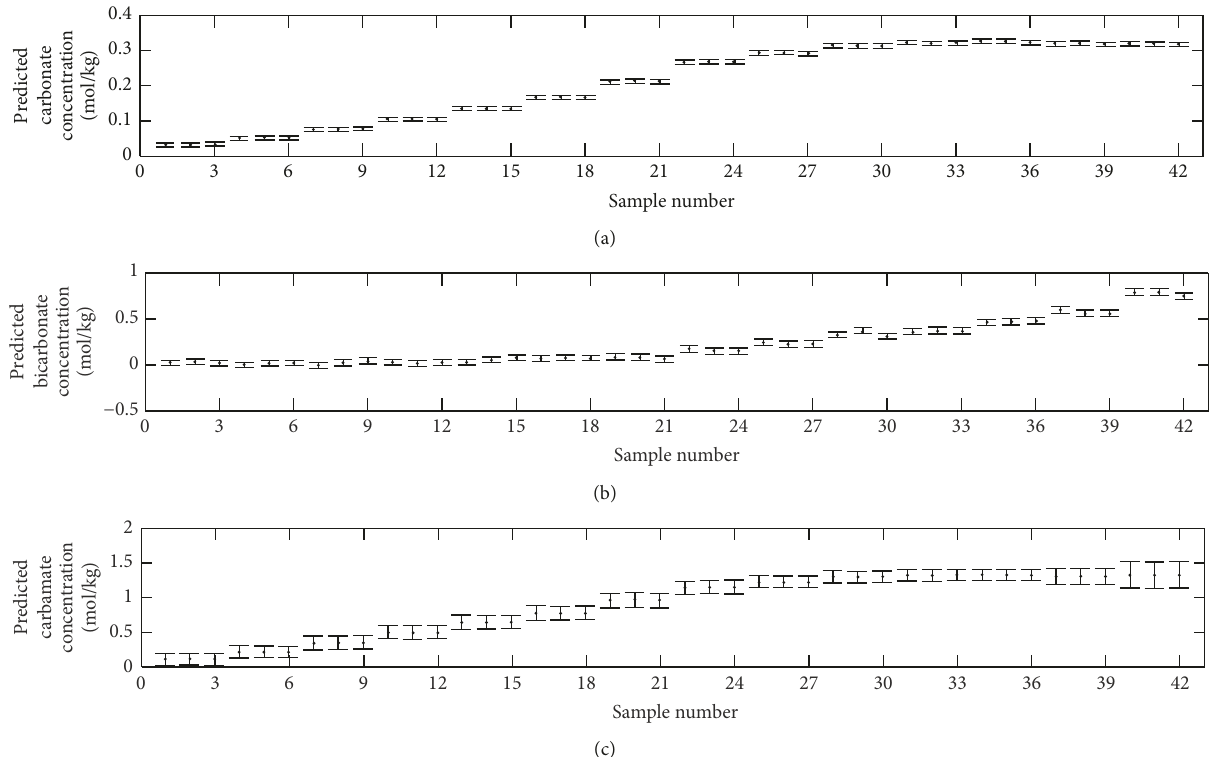
Figure 7: Predicted concentrations [mol/kg] of (a) carbonate; (b) bicarbonate; and (c)